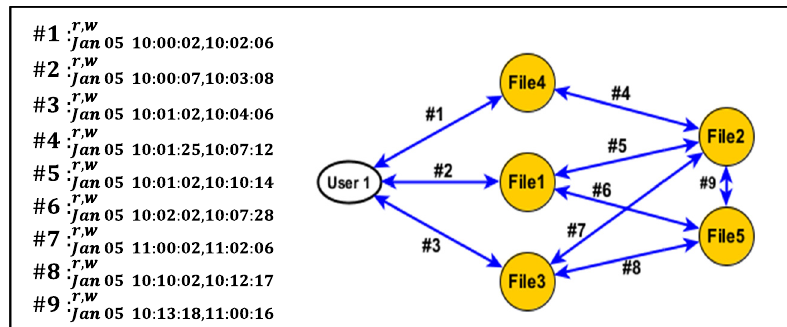
Figure 1: Example of an information fl ow